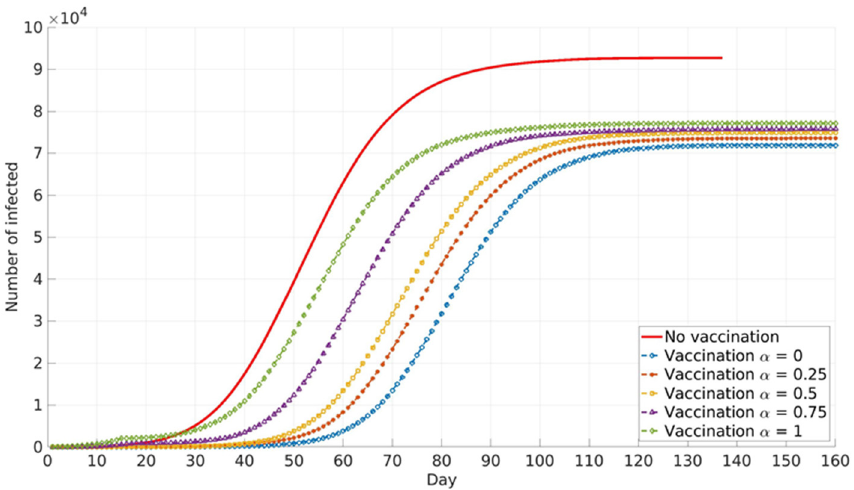
Figure 7. Vaccinated all healthcare workers, adults over 65 years, and adults from priority groups. The model predicted cumulative numbers of infected cases depending on social parameter α .